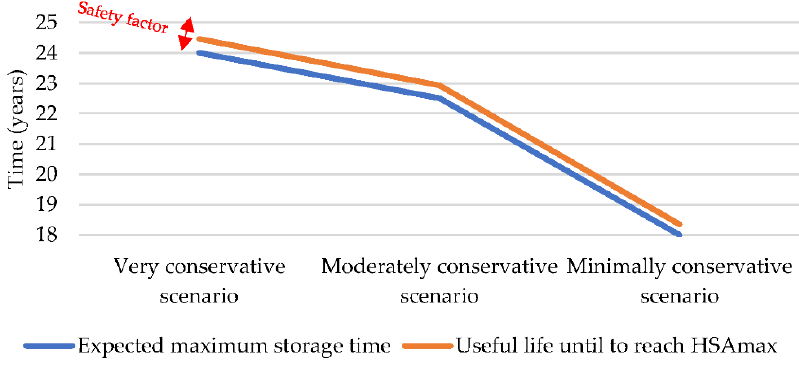
Figure 17. Validation and demonstration that the model provides a safety